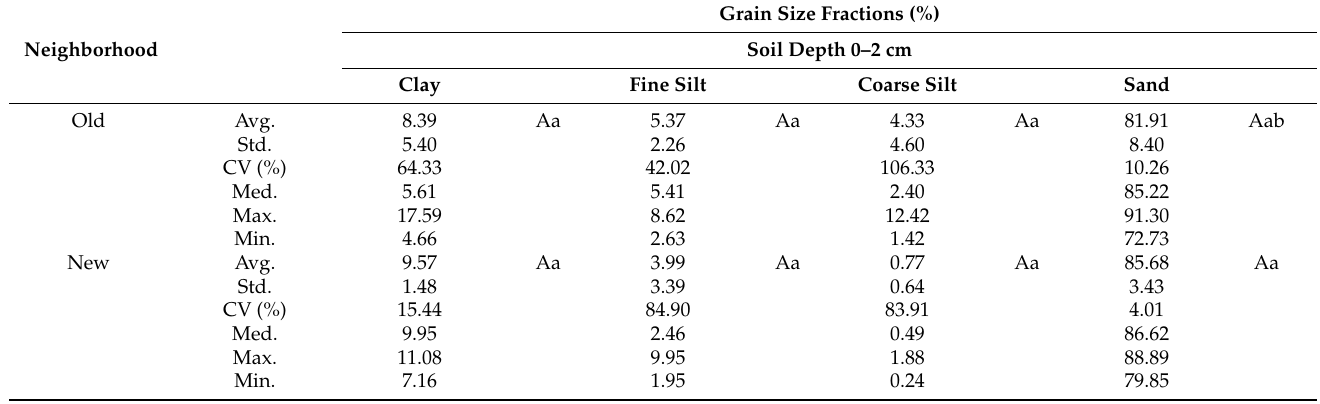
Table 2. Statistical parameters of Grain Size Fractions at three soil depths in the gardens of two city neighborhoods. N = 6 for each depth and neighborhood. For each depth, different capital letters within a column indicate significant differences between neighborhoods, and different small letters within a raw indicate significant differences between depths by Duncan’s Multiple Range Test at P =